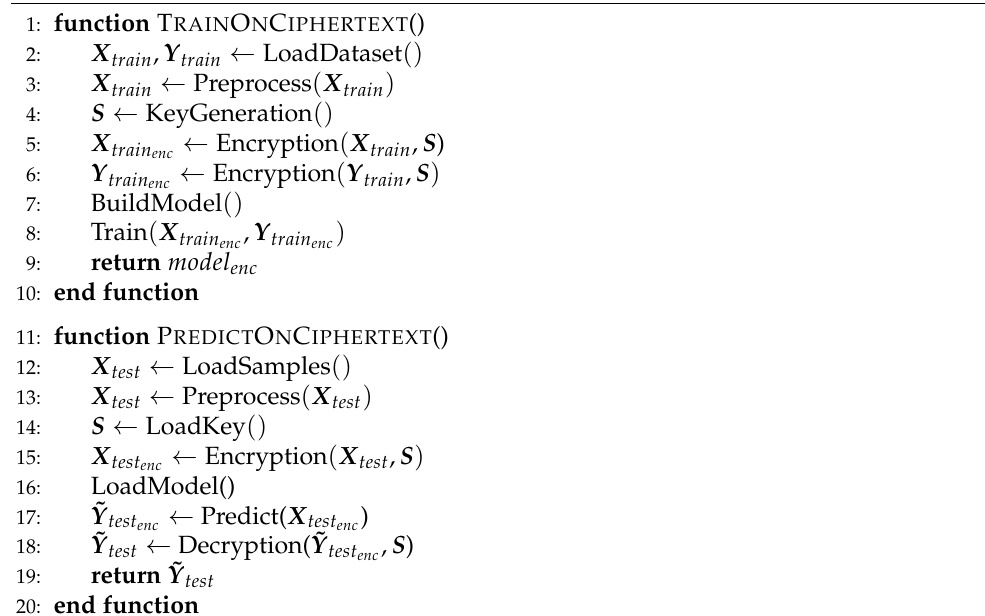
Algorithm 4 Deep learning-based analysis on ciphertext